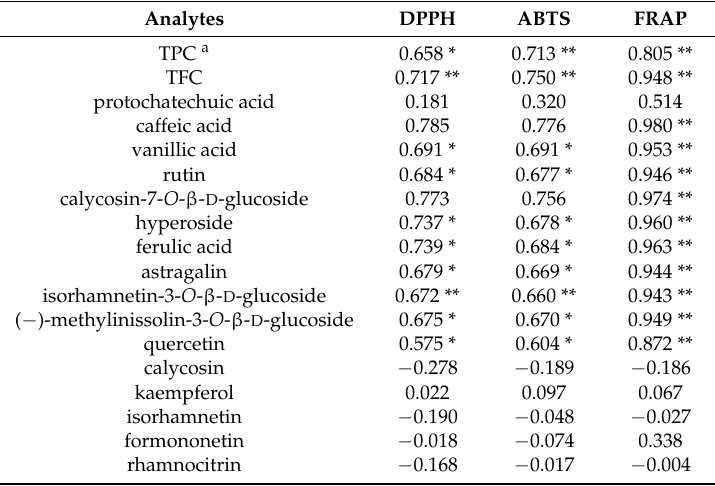
Table 6. Pearson’s correlation coefficients of antioxidant activities with phenolic acids and flavonoids contents for